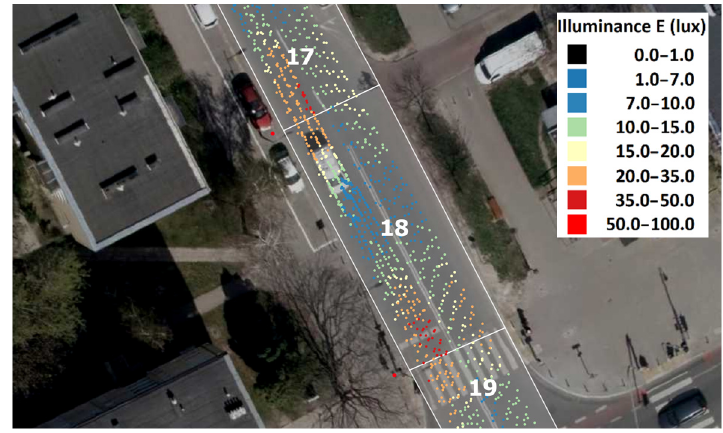
Figure A8. Example of five illuminance measurements in field No. 13.